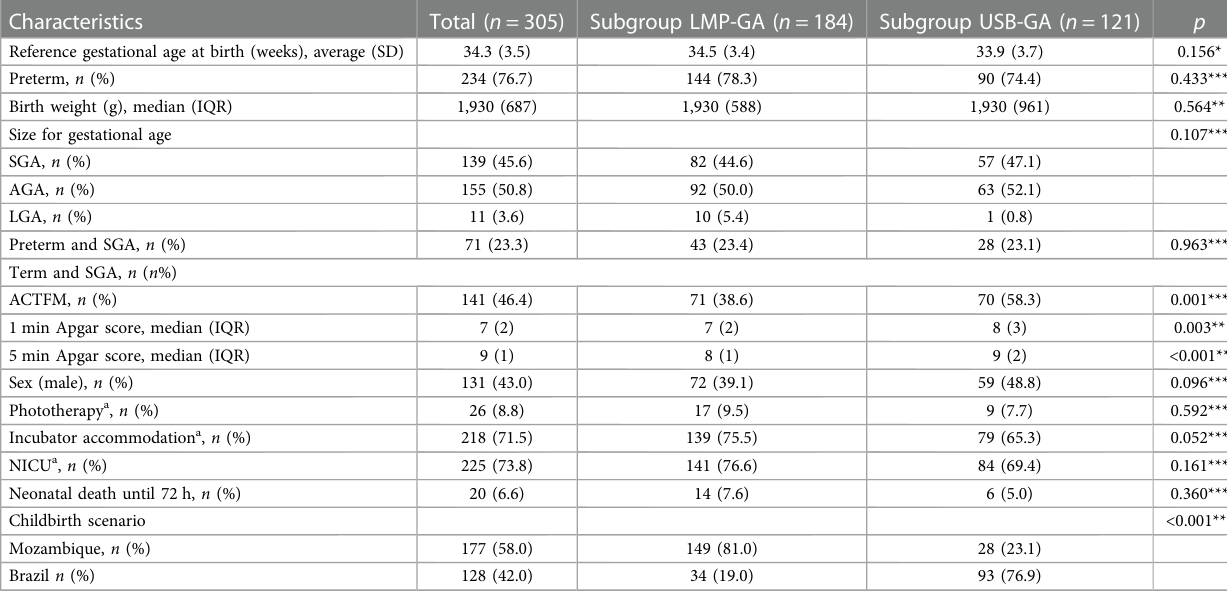
TABLE 1 Clinical characteristics of low-birth-weight newborns included in the